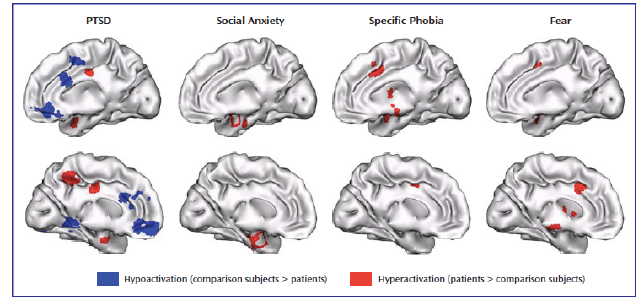
Figure 2. Brain imaging results of hypoactivation and hyperactivation due to PTSD and other mental problems and illnesses (Karam et al.,